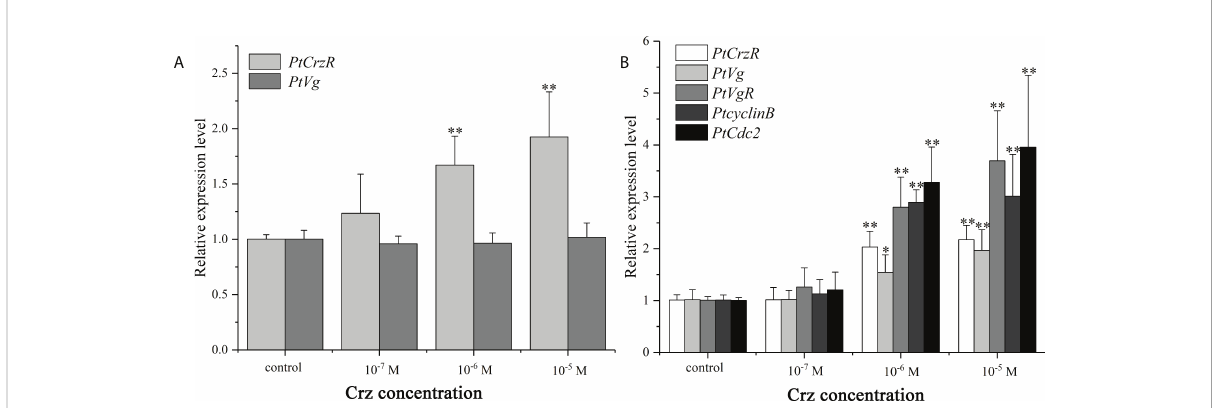
FIGURE 6 In vitro effect of synthetic Crz on the expression of PtCrzR and PtVg in the hepatopancreas explants (A) , and the expression of PtCrzR , PtVg , PtVgR , PtcyclinB , and PtCdc2 in the ovary explants (B) . Data are shown as mean ± SE (n=4). “ * ” represents signi fi cant differences (P < 0.05) and “ ** ” represents extremely signi fi cant differences (P < 0.01) from the control group.